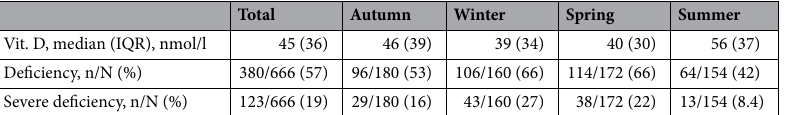
Table 2. The table presents median serum 25(OH)D levels and the prevalence of deficiency and severely deficiency for different seasons of the year. The table is based on the baseline measurement of all included participants ( n = 666). IQR 25–75 interquartile range; deficiency, serum 25(OH)D < 50 nmol/l; severe deficiency, serum 25(OH)D < 25